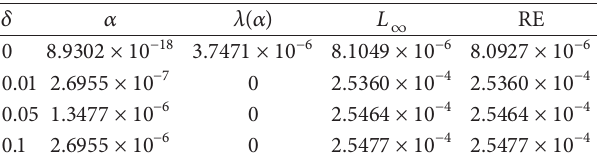
Table 3: 𝑇 = 1 , the objective function 𝜆(𝛼) , the 𝐿 ∞ , and the relative errors for 𝑓(𝑥) , with 𝛿 = 0, 0.01, 0.05, 0.1 .